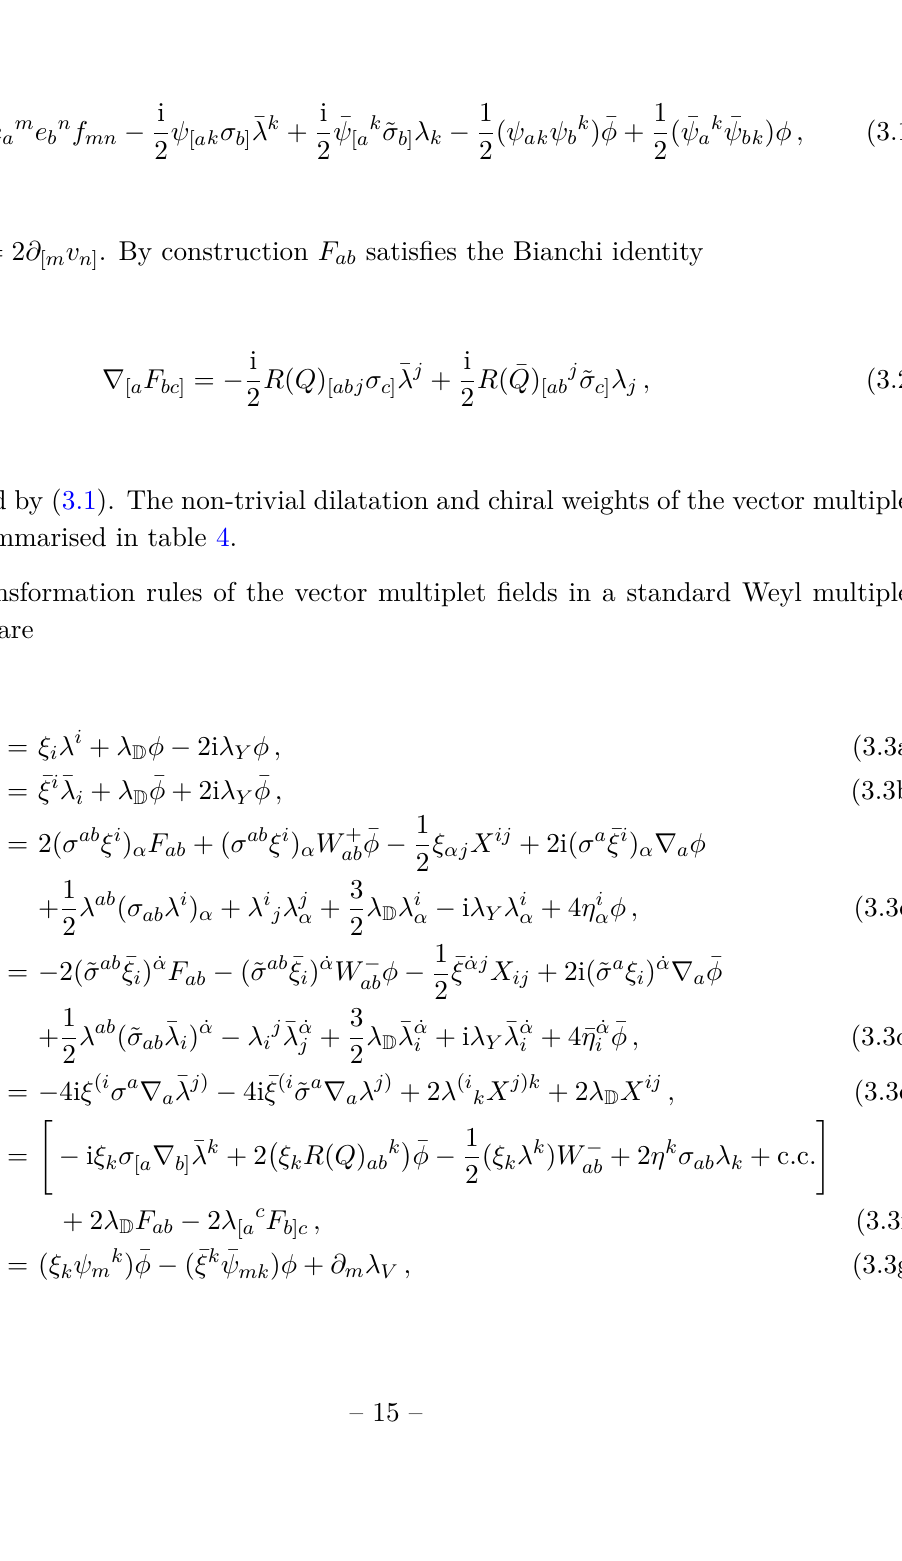
or, equivalently, its covariant real field strength m